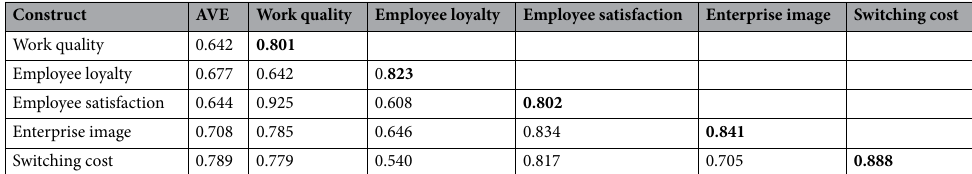
Table 4. The results of discriminant validity. Diagonals (in bold) represent the square root of the average variance extracted, while the other entries represent the correlations.